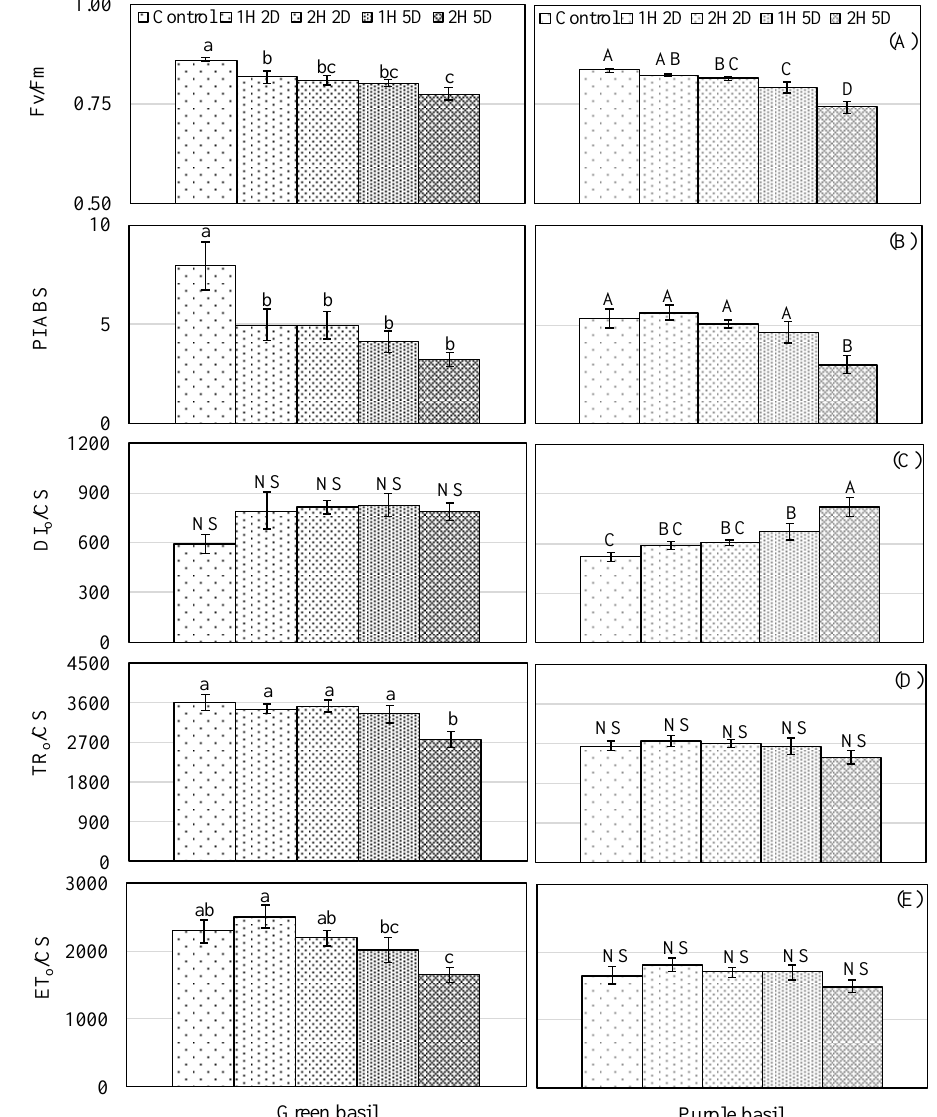
Figure 2. Chlorophyll fluorescence parameters, including maximal photochemical efficiency of Photosystem II (F v / F m ) ( A ), performance index (PI ABS, where “ABS” specifies that the reaction centers’ density is expressed per absorption) ( B ), dissipation of energy per cross section (DI 0 / CS) ( C ), trapped energy per cross section (TR 0 / CS) ( D ), and electron transport flux per cross section (ET 0 / CS) ( E ) of green basil ‘Improved Genovese Compact’ and purple basil ‘Red Rubin’ plants under di ff erent supplemental UV-B radiation treatments including control, 1H2D, 2H2D, 1H5D, 2H5D. Data were pooled from two photosynthetic photon flux density (PPFD) treatments. Means followed by the same lower / upper case letters are not significantly di ff erent for green / purple basil plants, according to Student’s t mean comparison ( p < 0.05). Bars represent standard errors.